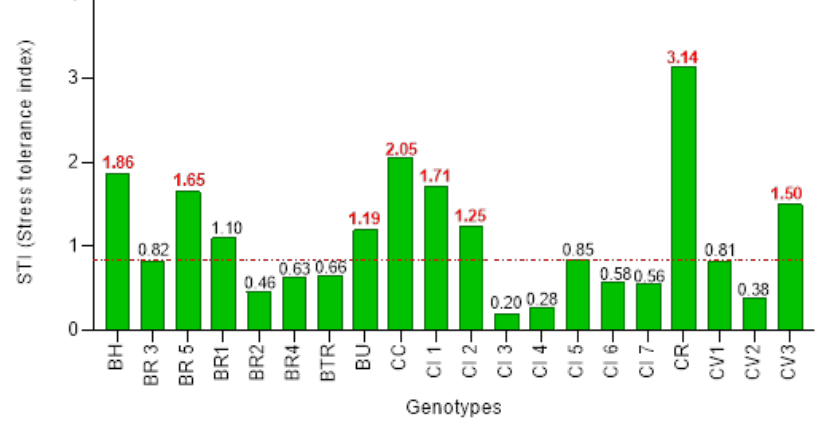
Figure 5. Stress tolerance index (STI) of 20 Brassica oleracea genotypes. The horizontal red line indicated the median value (0.83). The red font values above the vertical bar are the highest STI which indicated the most drought tolerant genotypes.